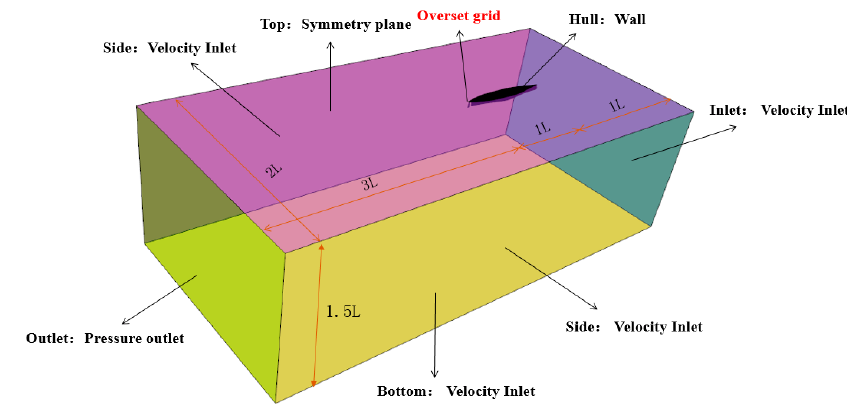
Figure 7. Computational domain and boundary conditions.